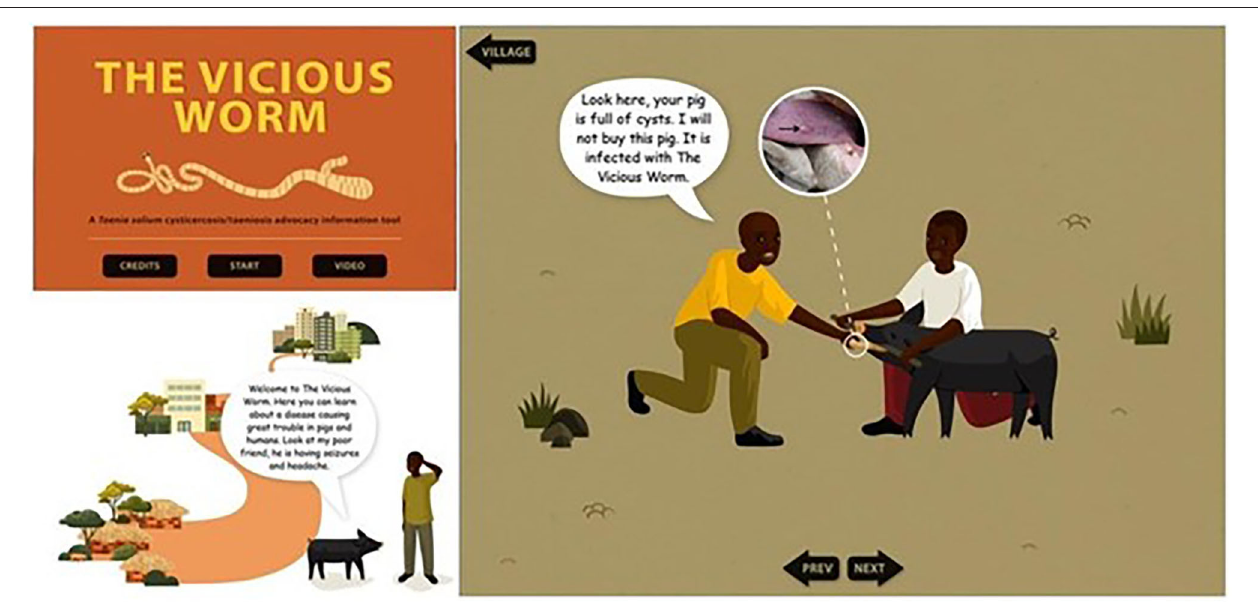
FIGURE 4 | Screenshots of the Vicious Worm computer program